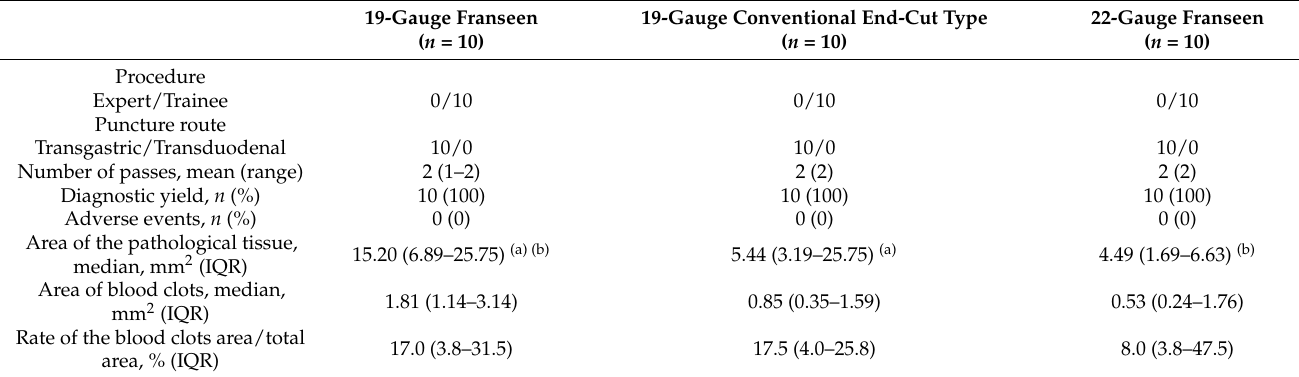
Table 2. Outcomes of EUS-FNA and FNB and data of pathological